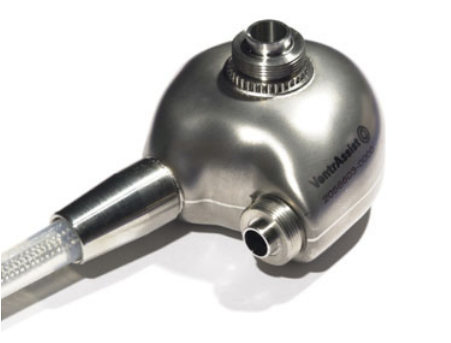
Figure 10 VentrAssist TM